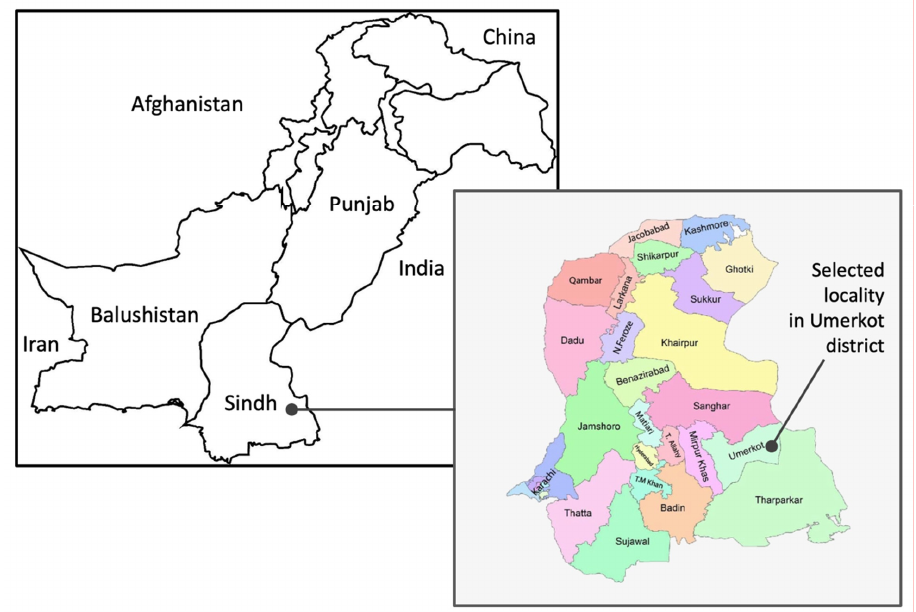
Figure 1. Locality surveyed to inform the local Thari populations about the benefits of locusts as a source of protein. Villagers collected locusts at night, by hand picking, in July–October 2019, using light traps (torches or headlights of vehicles) (Figure 2A,B). Locusts were stored in polypropyl- ene bags or other locally available containers (Figure 2C, D). Each bag was weighed (Metis electronic scale with a capacity of 100 kg). The people who consumed the locusts were interviewed about their methods of preparation and cooking, the quantity they consumed each day, and the quality of their taste. To control the locusts locally, we carried out four field trips into their type-locality and other surrounding villages, after the arrival of each of the swarms, to control the emergence of hoppers, the occurrence of hopper bands, and the insects’ behavior.